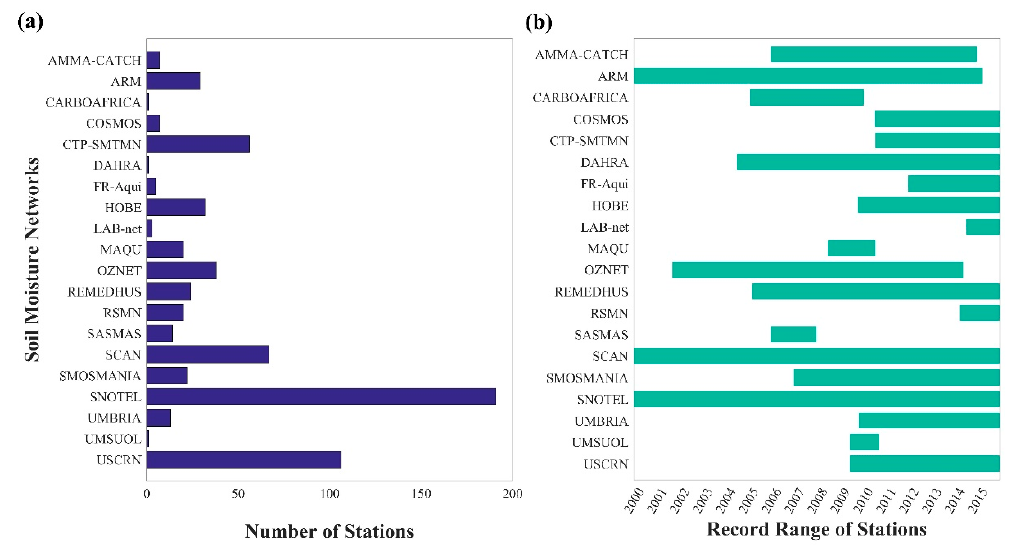
Figure 1. ( a ) Overview of the number of International Soil Moisture Network (ISMN) soil moisture stations and ( b ) average duration of stations per network used in the study after quality controls were applied.